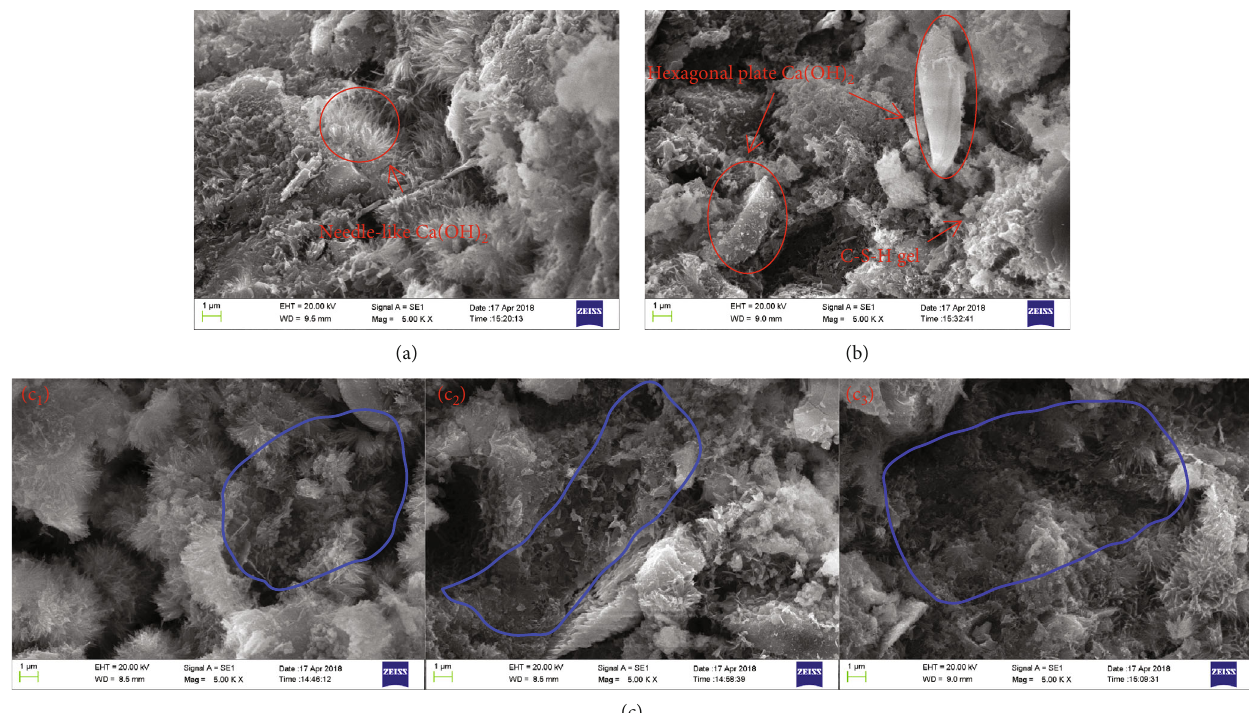
Figure 8: SEM images of di ff erent types of cement-based material samples (axial direction). (a) Pure samples; (b) pure samples with dispersant SXY-2 (0.75%BWOC); (c) samples with dispersant SXY-2 (0.75%BWOC) and additive FLA A ((c and (c ) 3%BWOC). 3